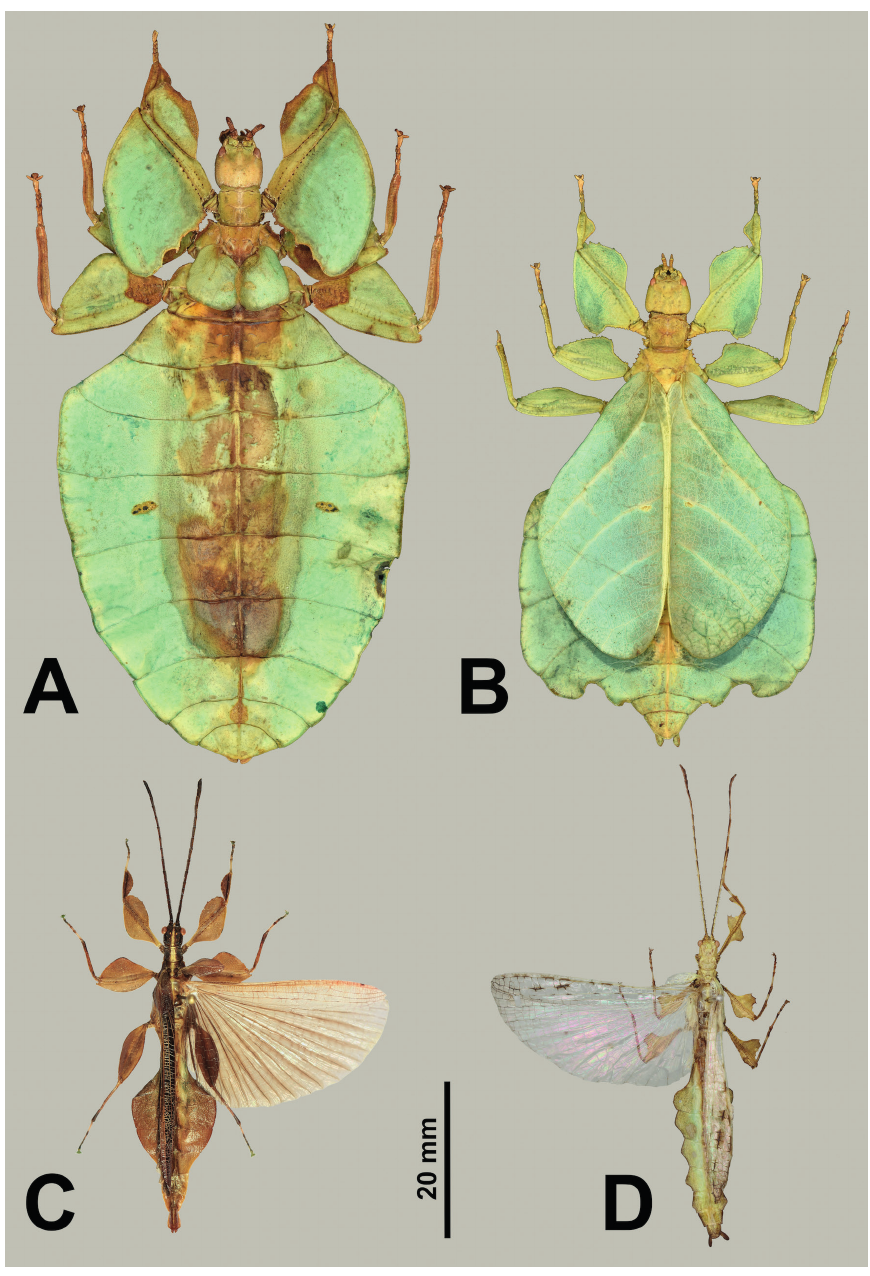
Figure 13. Dorsal habitus of adult Acentetaphyllium gen. nov. and Nanophyllium to help illustrate the morphological differences/similarities between these two genera. Images scaled to relative size; scale bar associated with all images A Acentetaphyllium brevipenne female (Coll TM) B Nanophyllium chitoniscoides (Größer, 1992) female (Coll TM) C Acentetaphyllium stellae comb. nov. holotype male (SDNHM) D Nanophyllium rentzi holotype male (NHMUK) A, B photographs by Rene Limoges (IMQC) C photograph by first author D photograph by Paul Brock